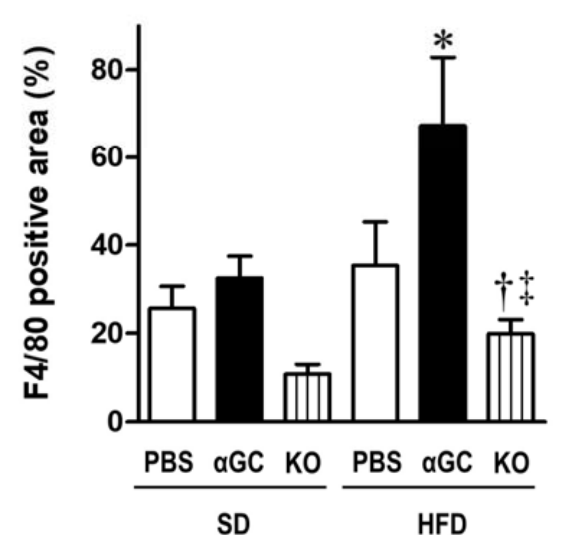
Figure 4. Representative photomicrographs of anti-F4/80 immunohistochemistry of cross-sections at the brachiocephalic artery ( A ) and summary data of anti-F4/80 positive area ( B ) from 6 groups of SD-PBS (n = 4), SD- α GC (n = 6), SD-KO (n = 3), HFD-PBS (n = 18), HFD- α GC (n = 16), and HFD-KO (n = 7) mice. Scale bar = 100 µ m. * p < 0.01, † p < 0.05 vs. HFD-PBS, and ‡ p < 0.01 vs. HFD- α GC by ANOVA. All data are expressed as means ± S.E.